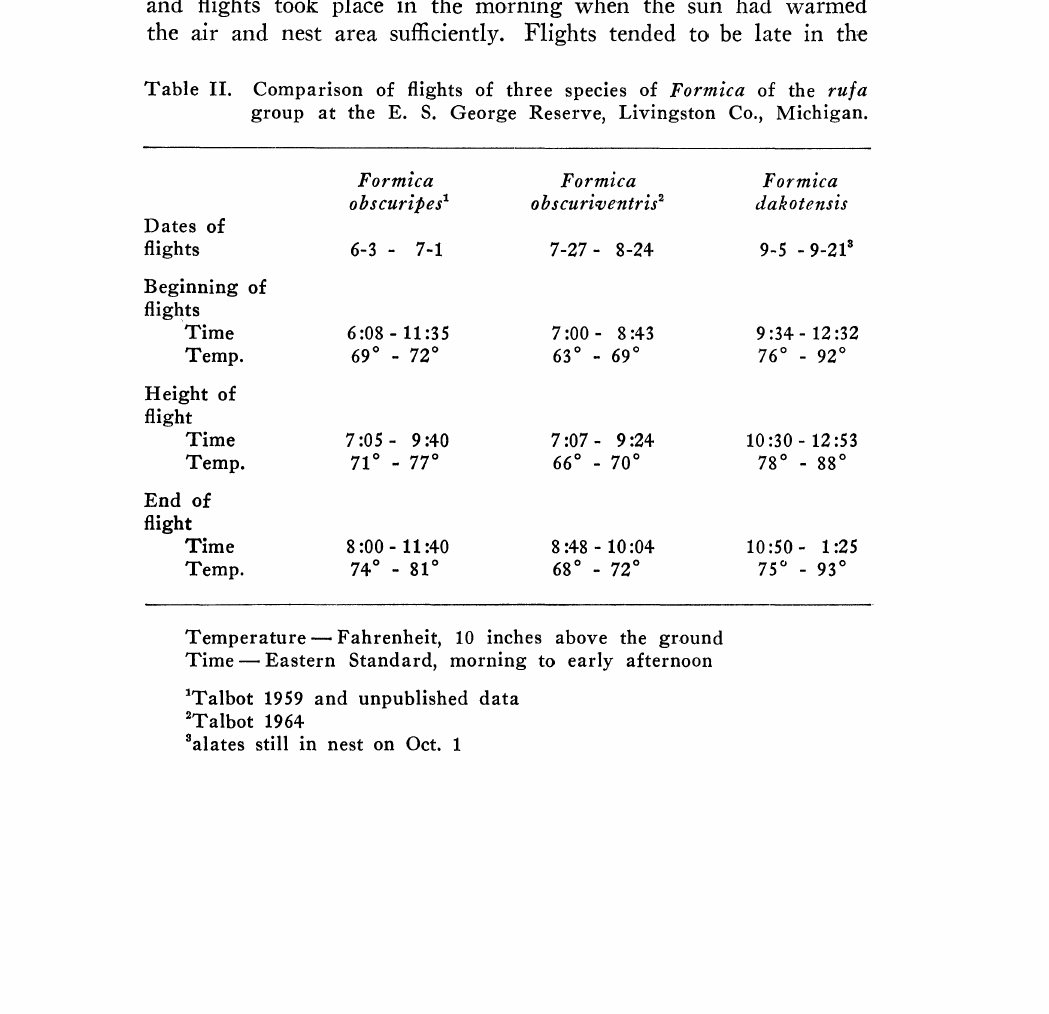
Table II. Comparison of flights of three species of Formica of the rufa group at the E. S. George Reserve, Livingston Co., Michigan. Formica Formica Formica o b curipe o b cu rieentris dak e nsis Dates